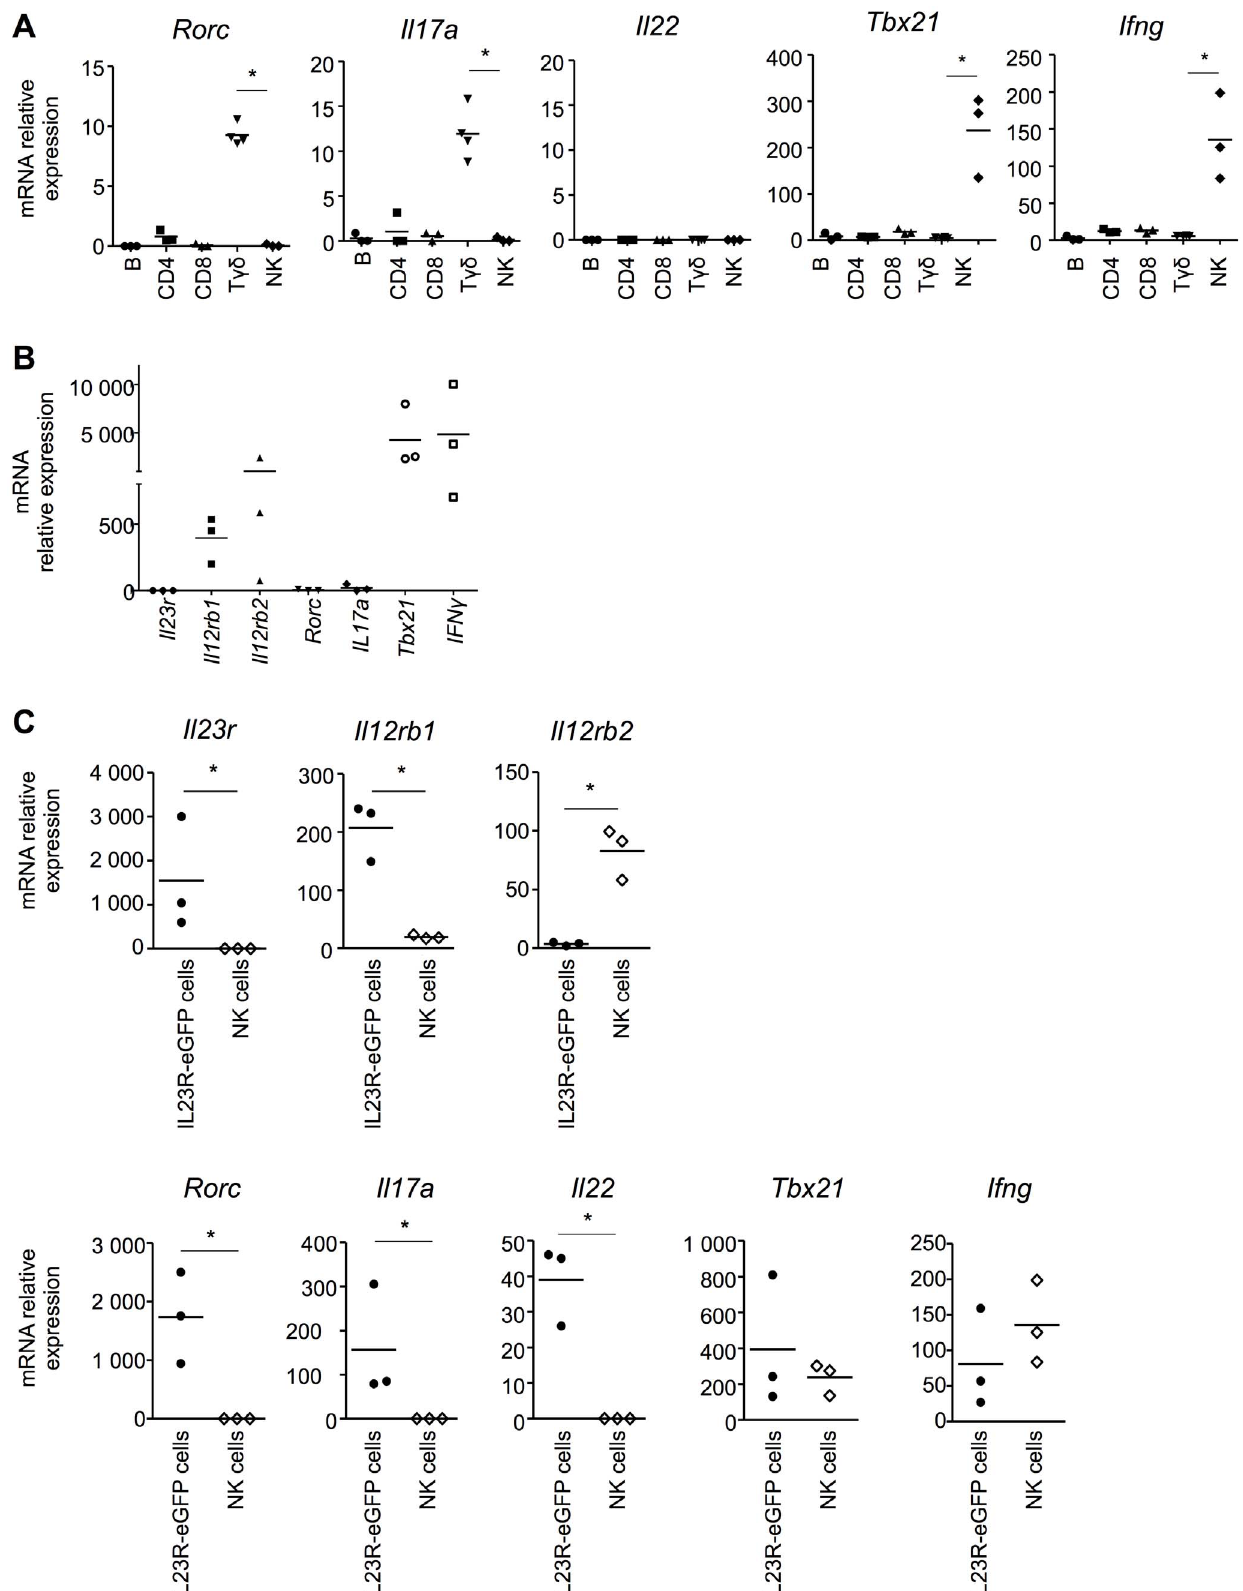
Figure 2. Il23r expressing cells exhibit a mixed Th1/Th17 signature profile. (A) The relative mRNA transcription level of Rorc , Il17a , Il22 , Tbx21 , and Ifng in sorted murine spleen cells is shown. (B) The relative mRNA transcription level of Il23r , Il12rb1 , Il12rb2 , Rorc , Il17a , Tbx21 and Ifng in cd